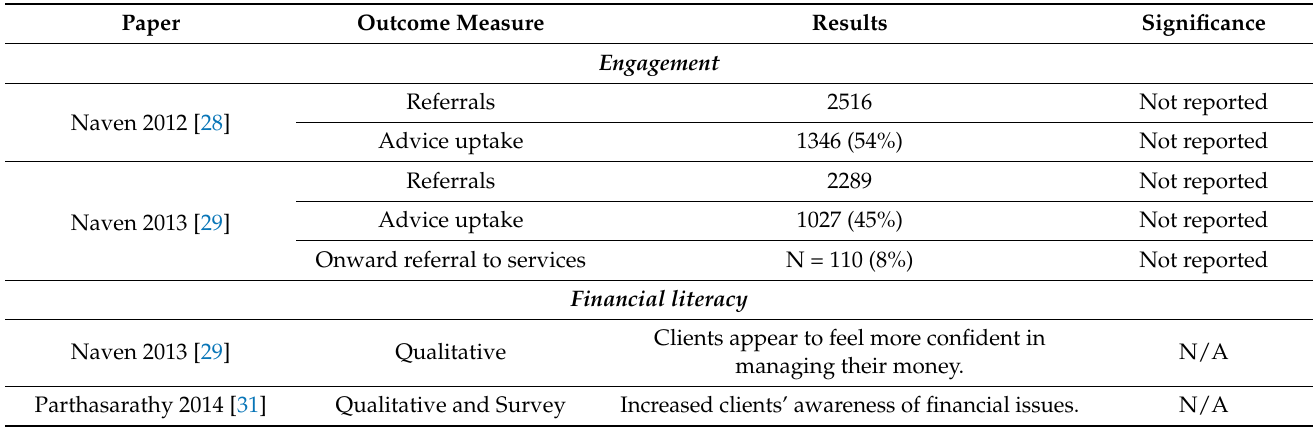
Table 4. Non-Financial